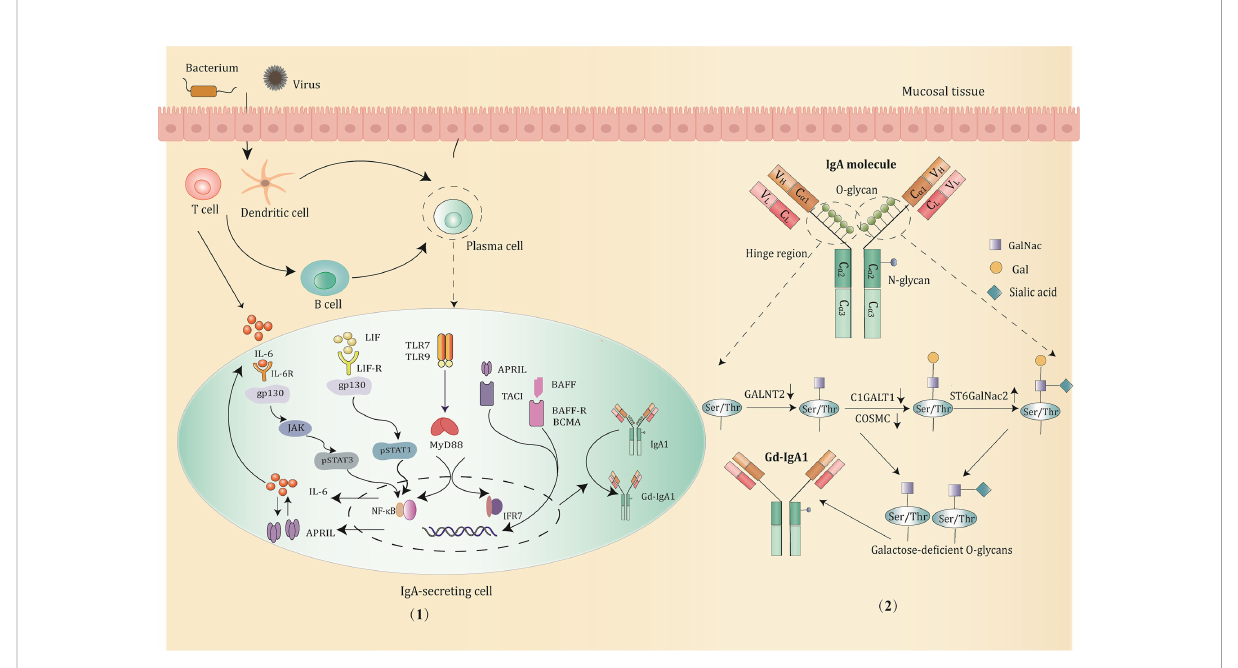
FIGURE 2 The production and major regulatory mechanisms of Gd-IgA1. (1) B cells in the mucosa differentiate into IgA1-secreting plasma cells and produce IgA1 through class switching in a T-cell-dependent or T-cell-independent manner when stimulated by pathogens, such as bacterium and virus. Then, the abnormal activation of signaling pathways promotes the production of Gd-IgA1 through altering the expression and activity of the key glycosyltransferases. Potential signaling pathways involved are mainly below: IL-6 activates the STAT3 pathway via binding to its gp130 receptor; LIF binds the LIF-R/gp130 receptor and activates the STAT1 pathway; TLRs (TLR7/TLR9) activation induce production of IL-6 and APRIL, which function synergistically to promote the generation of Gd-IgA1; BAFF or APRIL signaling through the BAFF receptors, such as TACI, BAFF-R, BCMA prevents degradation of NF- k B and in fl uence the O-glycosylation of IgA1. (2) The structure and O-glycosylation process of IgA1. IgA1 has O-glycans located in the unique hinge region, with 3 to 6 O-glycosylation sites consisting of serine or threonine residues. The low expression of GALNT2, C1GALT1, and COSMC, and upregulation of ST6GalNac2 can hinder the IgA1 glycosylation process, resulting in the exposure of terminal GalNac residues and overproduction of